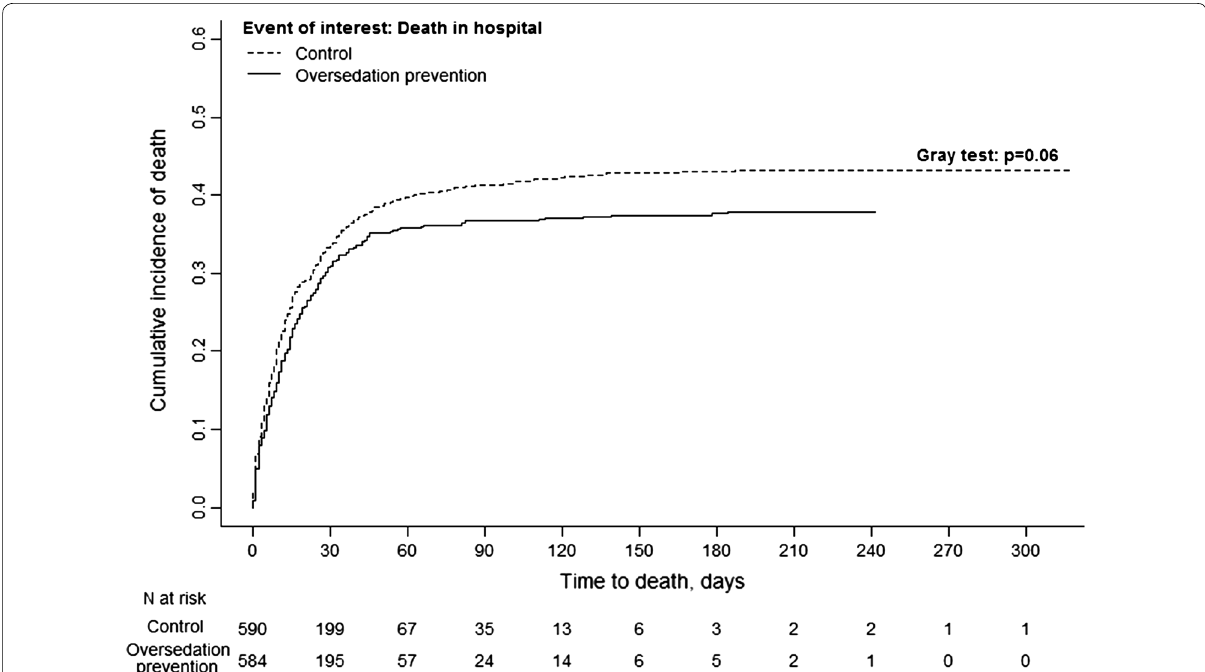
Fig. 3 Cumulative incidence of deaths in the hospital. The cumulative incidence of hospital death did not differ significantly between the two groups (220 in oversedation prevention group vs. 253 in the control group): hazard ratio for the oversedation prevention group versus the control group, 0.85; 95% confidence interval, 0.71–1.01; p 0.06. For the analysis of time from randomization to death in the hospital, alive hospital = discharge was handled as a competing